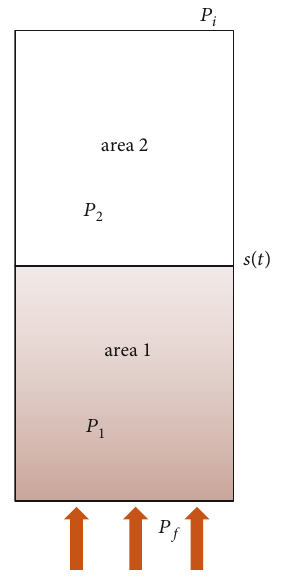
Figure 1: Schematic diagram of fracture-wall hydromechanical